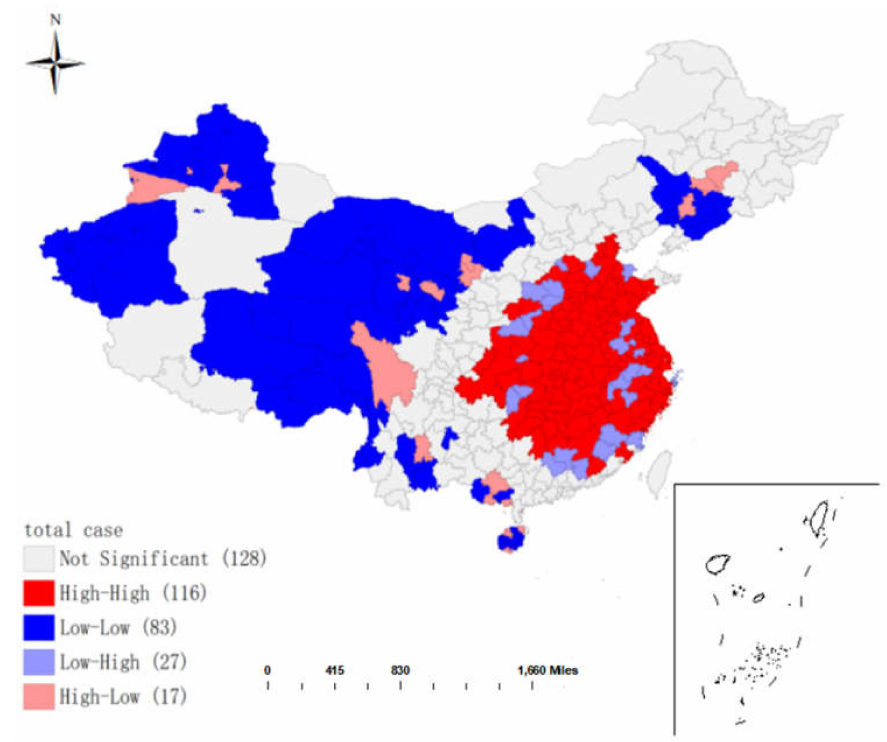
Figure 5. Local Indicator of Spatial Association (LISA) cluster map of the cumulative number of diagnoses on 8 April